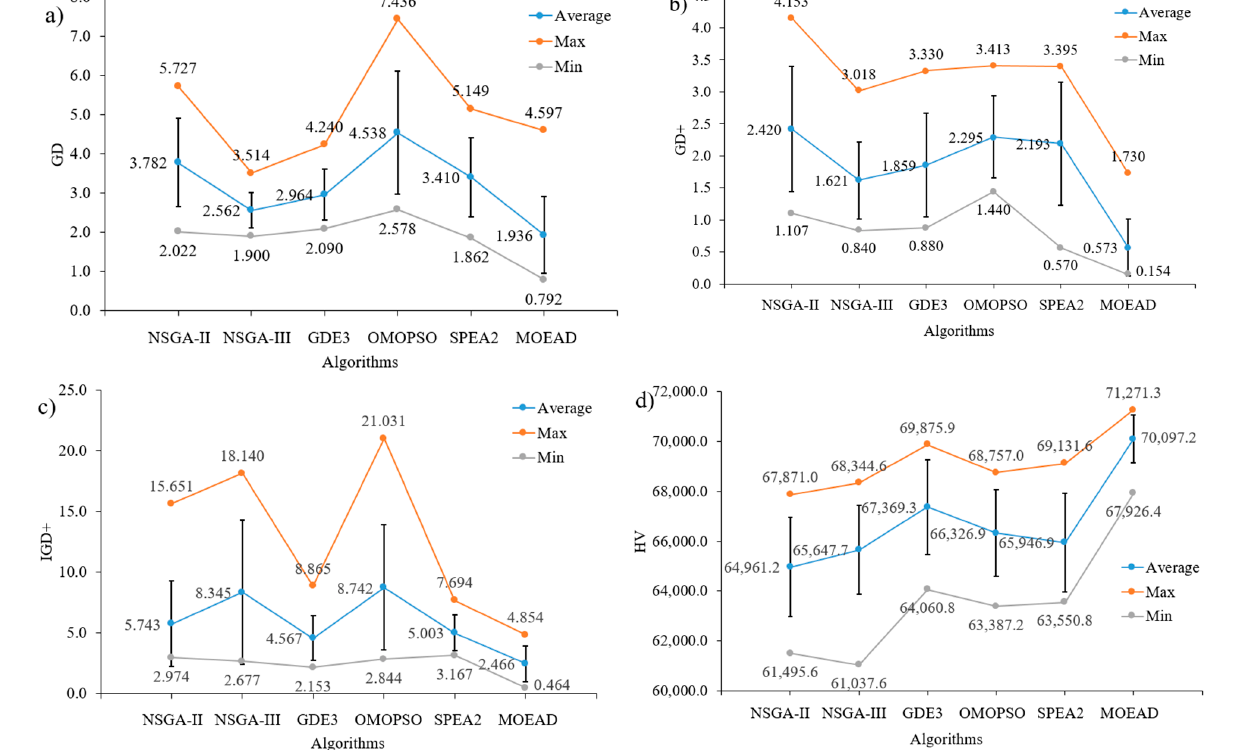
Figure 5. GD, GD+, IGD+, and HV of the MOO algorithms of the 10-bar truss: ( a ) GD; ( b ) GD+; ( c ) IGD+; ( d ) HV.